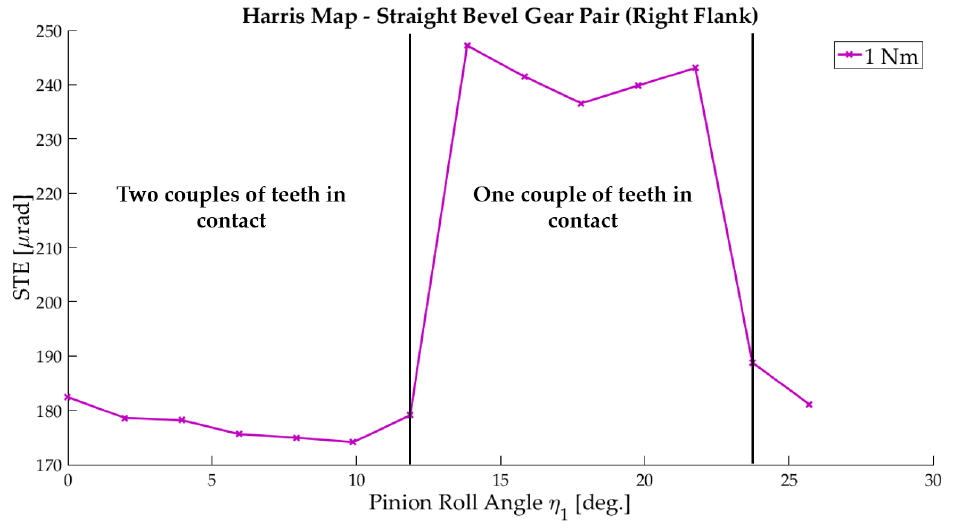
Figure 8. STE curve for 1 Nm.